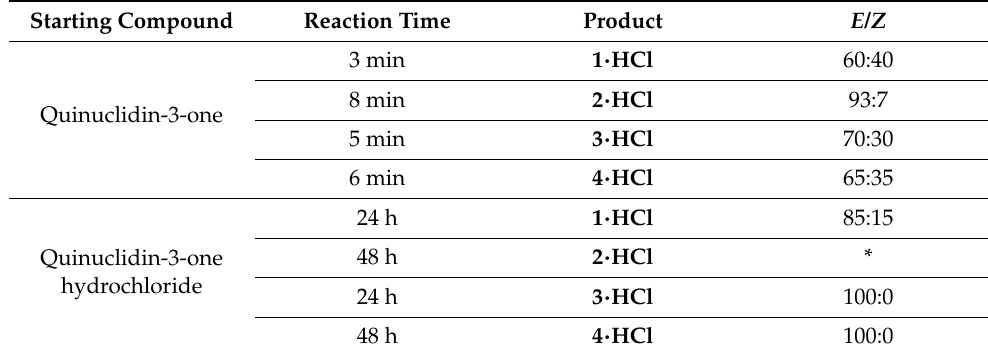
Table 1. Classical synthesis in solution (Method A) of compounds 1 – 4 . E / Z ratio was determined